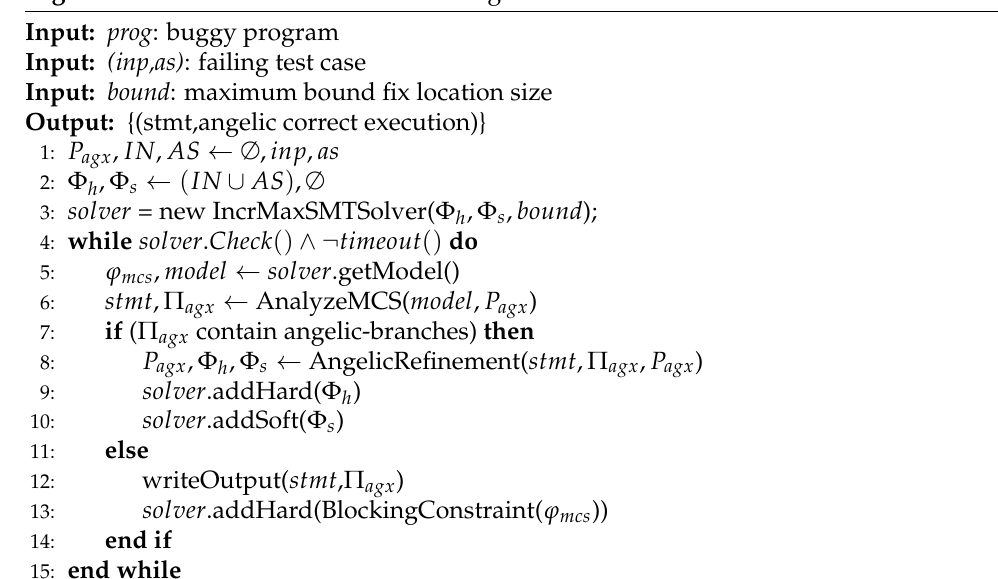
Algorithm 1 Overall Fault Localization